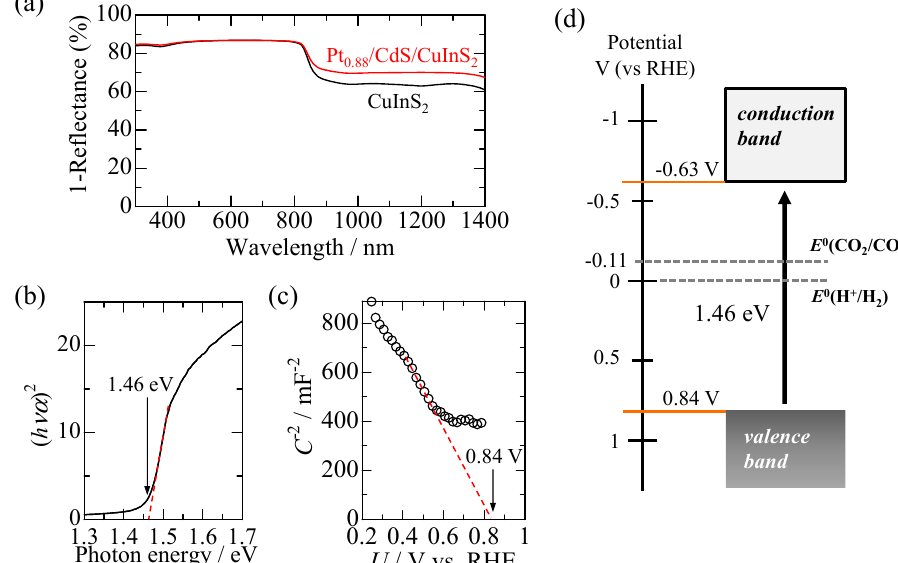
Figure 2. ( a ) UV-vis-NIR absorption spectra of CuInS 2 and Pt 0.88 / CdS / CuInS 2 electrodes. ( b ) Tauc plot and ( c ) Mott–Schottky plot of CuInS 2 electrode. ( d ) Band alignment of the synthesized CuInS 2 electrode deduced from the results shown in ( a – c ).